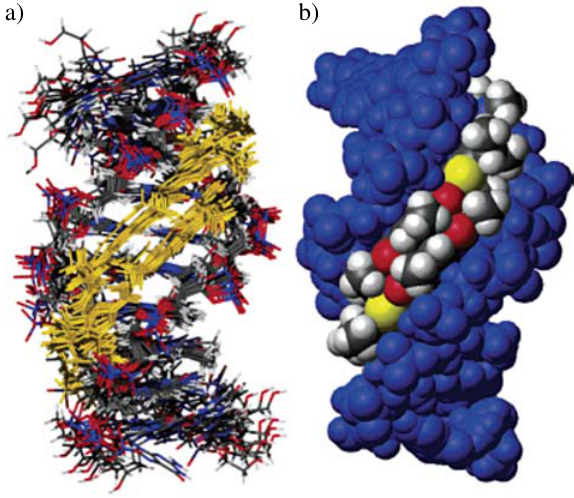
Figure 1. Representation of the solution structure of the complex between two Thiazotropsin A molecules (1 and 2 ) determined in aqueous solution by NMR spectroscopy. (a) Overlay of a family of 10 lowest energy structures taken from different parts of the mole- cular dynamics trajectory; the ligand is represented in gold. (b) CPK representation of the average structure looking into the minor groove: ligand atoms are coloured by atom type; all DNA atoms are shown in blue (reprinted with permission from J. Am. Chem. Soc. , 2004 , 126 , 11338. Copyright 2004 American Chemical Society).